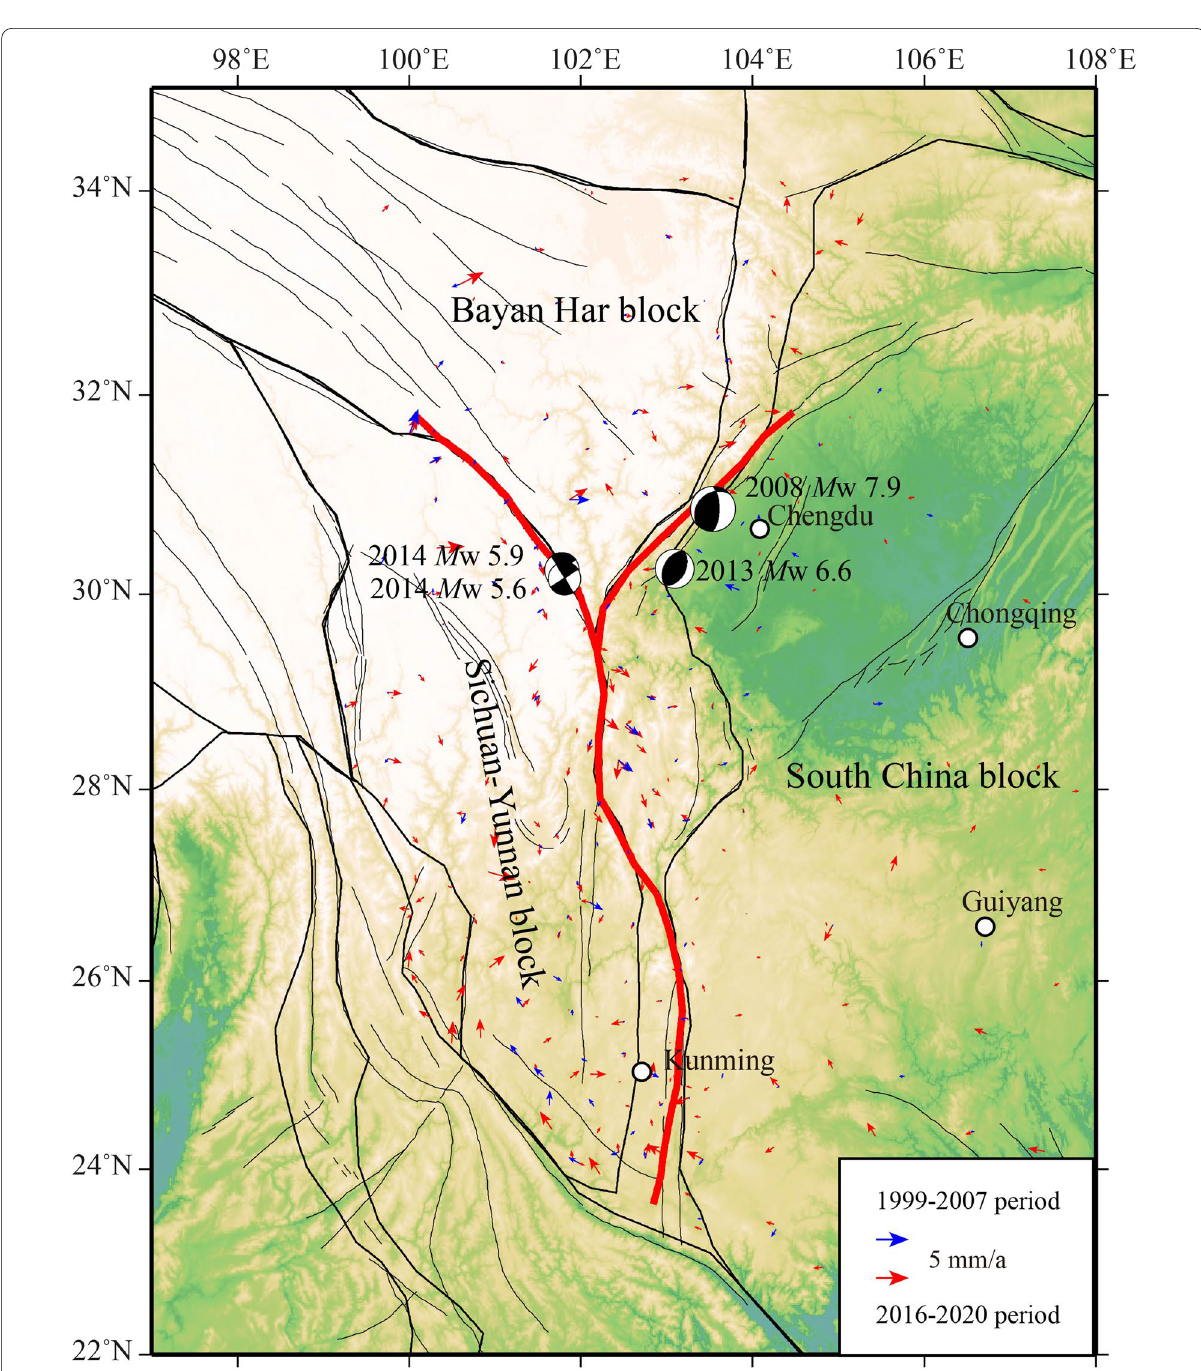
Figure 7 Velocity residuals for the two time periods for the best-fit model. Bold black lines represent the boundaries of the secondary blocks. Bold red line is the fault model correspond to the Xianshuihe–Anninghe–Zemuhe–Xiaojiang fault system and the Longmenshan fault